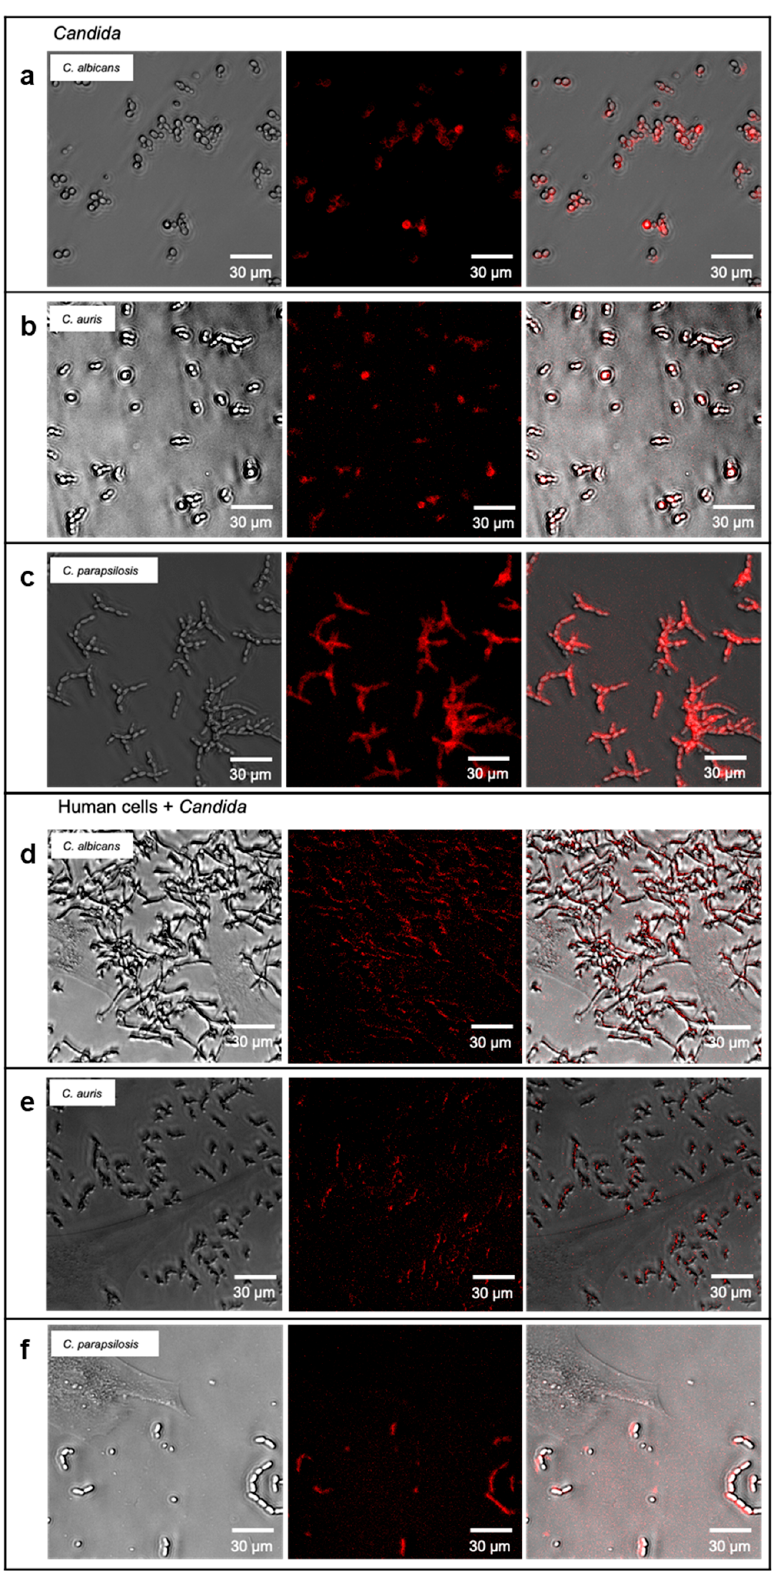
Figure 4. Specific labeling of individual Candida cells by the SELEX-derived aptamer library R8 . Experimental set-up was as in Figure 3b–d with the difference that individual Candida species were used instead of mixes. Panels ( a – c ): Candida species alone as positive controls. Panels ( d – f ): Candida species on human cells.